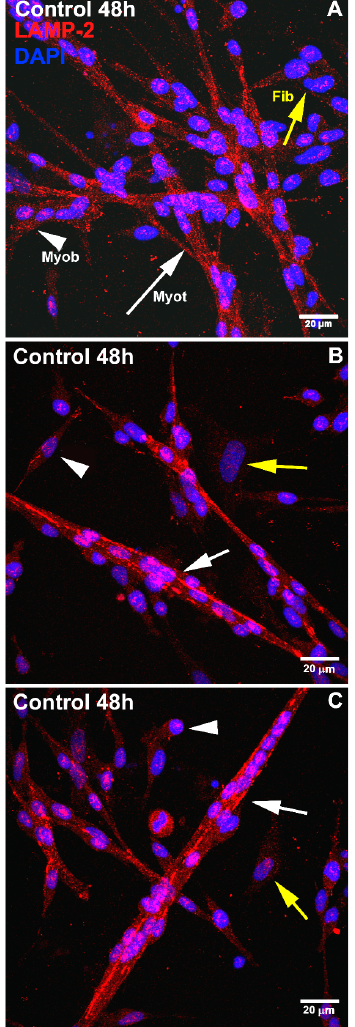
Figure 2 . LAMP2 distribution changes during chick myogenesis. Chick muscle cells were grown for 48 h and double-labeled with antibodies against LAMP2 (red, A – C ) and with the nuclear dye DAPI (blue, A – C ). The three images represent myogenic cultures grown for 48 h ( A – C ). White arrows represent myotubes (Myot), white arrowheads represent myoblasts (Myob), and yellow arrows represent fibroblasts (Fib). LAMP2 labeling was found in a tubular distribution in the cytoplasm of multinucleated myotubes (Figure 2). Furthermore, myotubes showed increased labeling of LAMP2 as compared to myoblasts and fibroblasts. LAMP2 labeling in fibroblast cells was weak. Scale bars in ( A – C ) = 20 μ m.